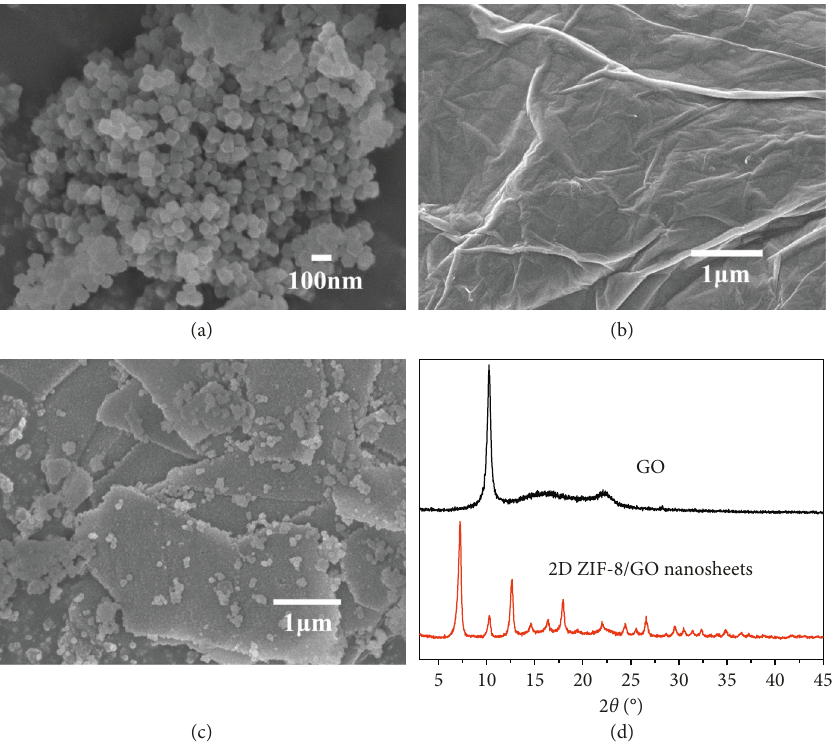
Figure 1: SEM image of different samples: (a) ZIF-8; (b) GO; (c) ZIF-8/GO nanosheets. (d) XRD pattern of different samples (GO and